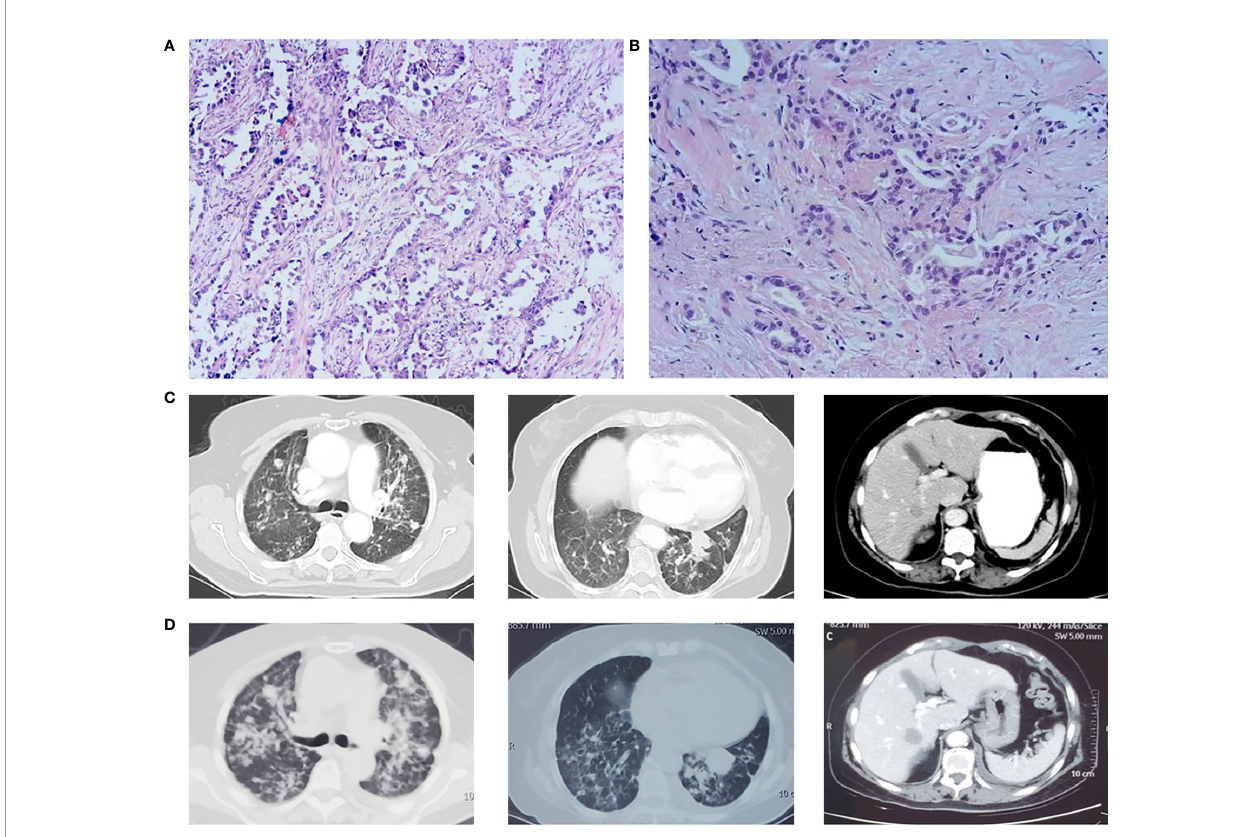
FIGURE 2 | (A) Pathological biopsy on October 22, 2018. (B) Pathological biopsy on November 11, 2020. (C) Lung lesion progression and liver metastasis on October 13, 2020. (D) Lesion progression in March 2021 after osimertinib